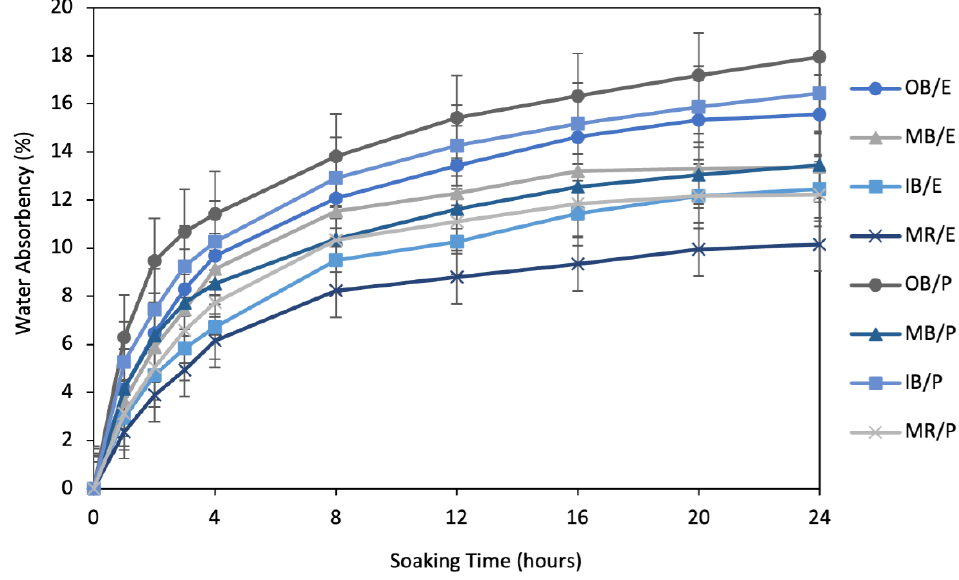
Figure 6. Water absorbency flow of 15% NaOH-treated composite samples, by soaking time up to 24 h.